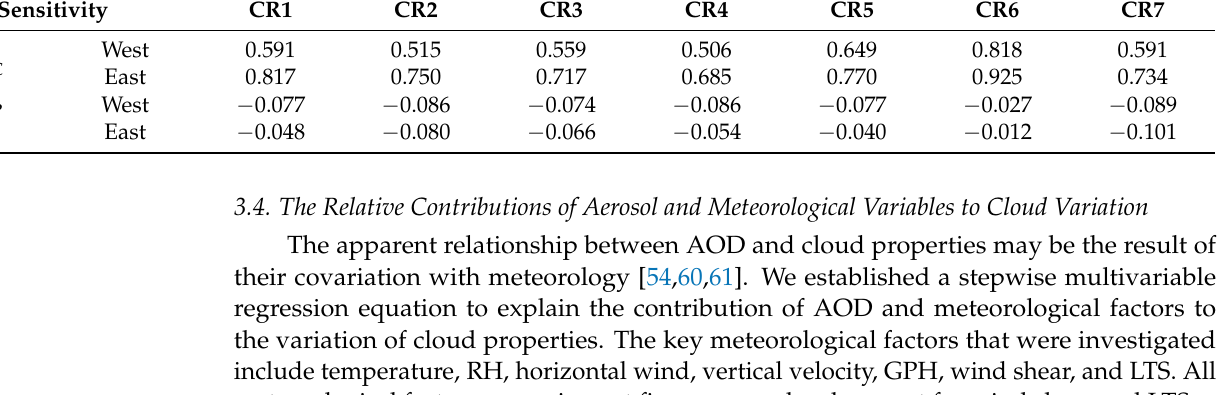
Table 2. The sensitivities of TCC/CTP to AOD for different cloud regimes and regions.